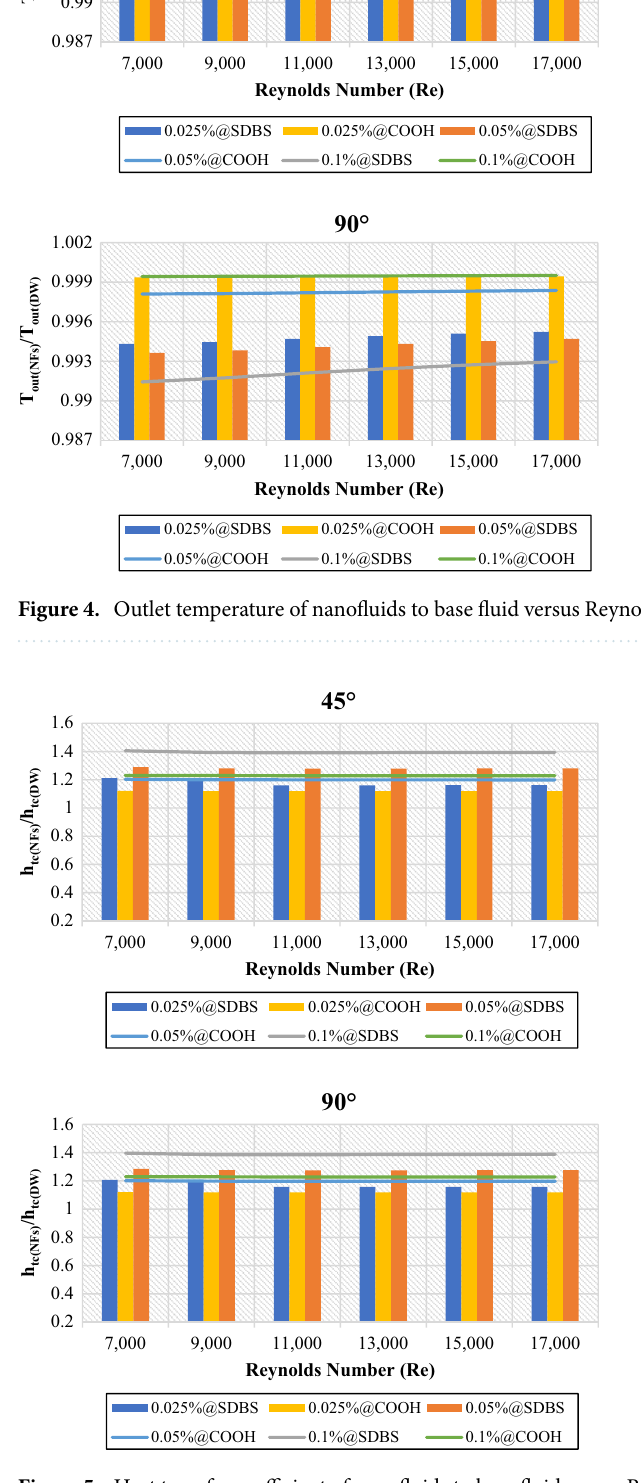
Figure 5. Heat transfer coefficient of nanofluids to base fluid versus Reynolds numbers for 45° and 90°